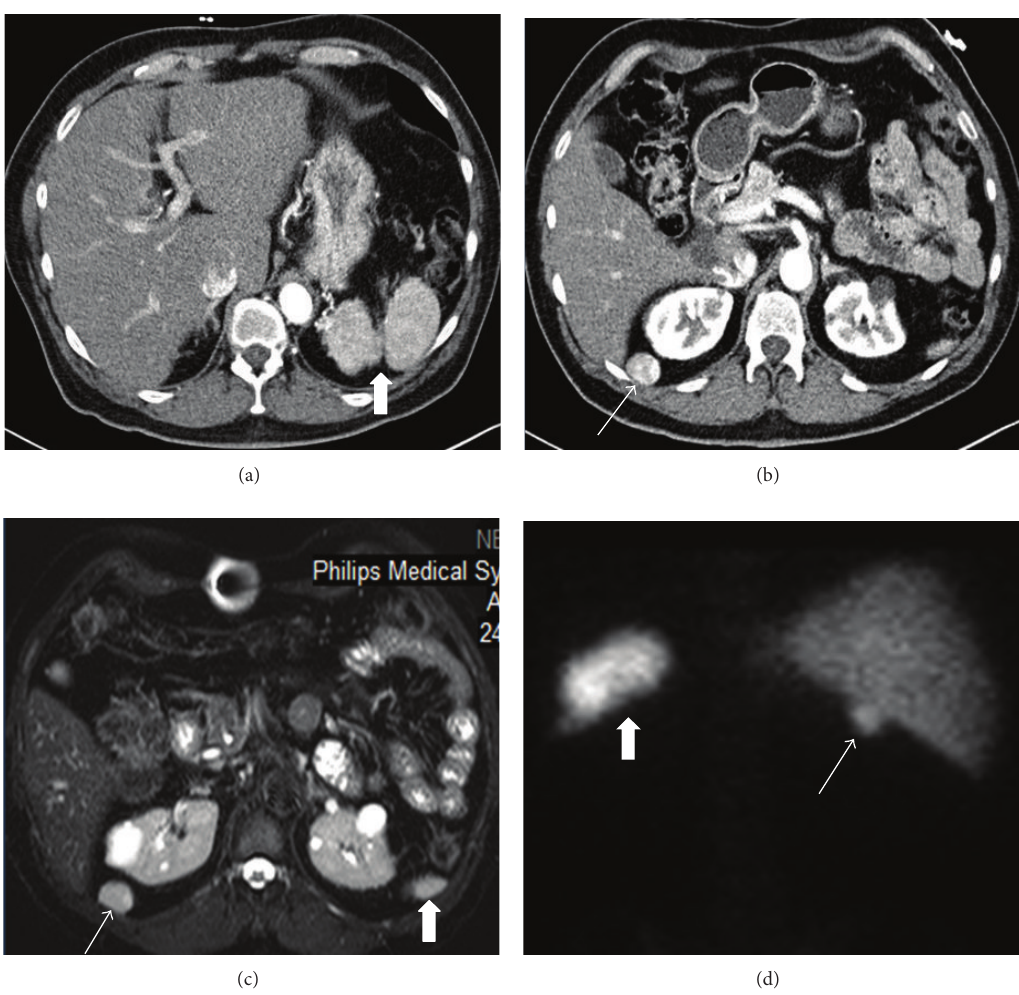
Figure 10: Splenosis in a 62-year-old male patient with a history of splenic trauma and splenectomy. Axial contrast enhanced CT images (a, b) show two splenic fragments (thick arrow) on the left upper quadrant (a) and a nodular mass (arrow) with a heterogenous contrast enhancement pattern as splenic tissue posterior to the liver and kidney (b). Axial T2 weighted image (c) demonstrates similar signal intensity of both the nodular mass (arrow) and inferior pole of the splenic fragments (thick arrow). Technetium-99 m posterior scintigraphy image (d) also shows uptake of the nodular mass (arrow) as splenic tissues on the left (thick arrow).